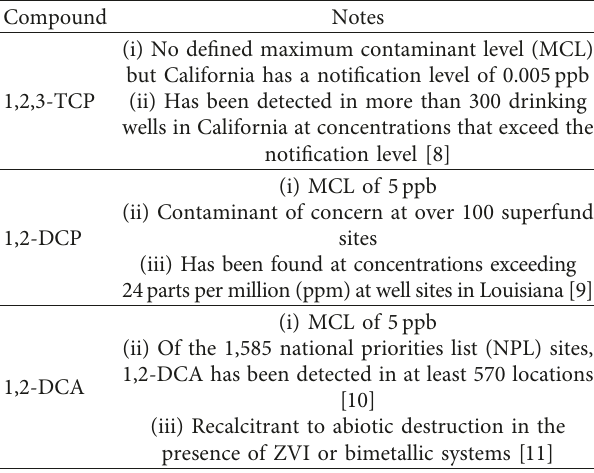
Table 1: Summary of environmental risks of chlorinated alkanes. Compound